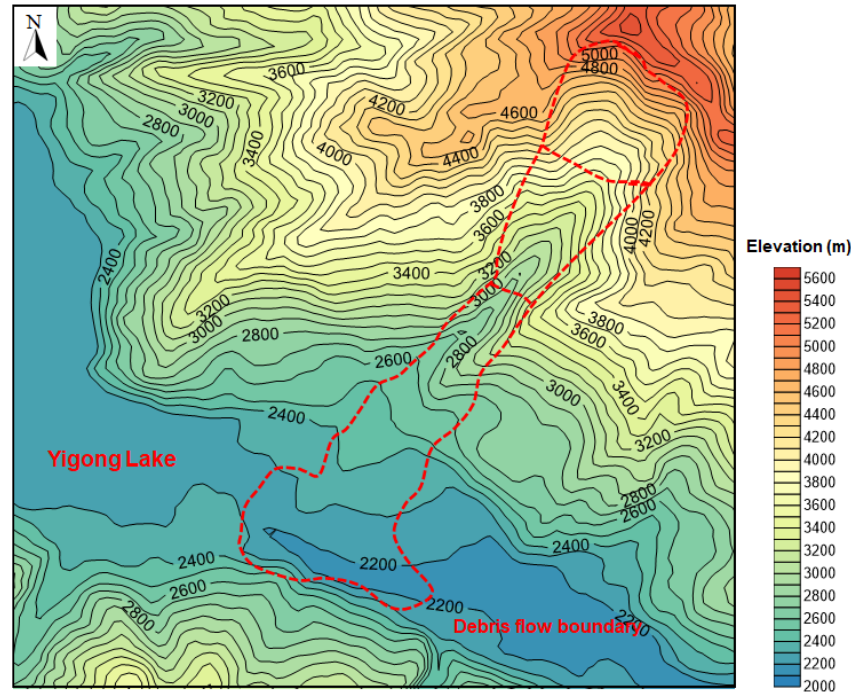
Figure 3. Topographic contour map of the Yigong debris flow gully.